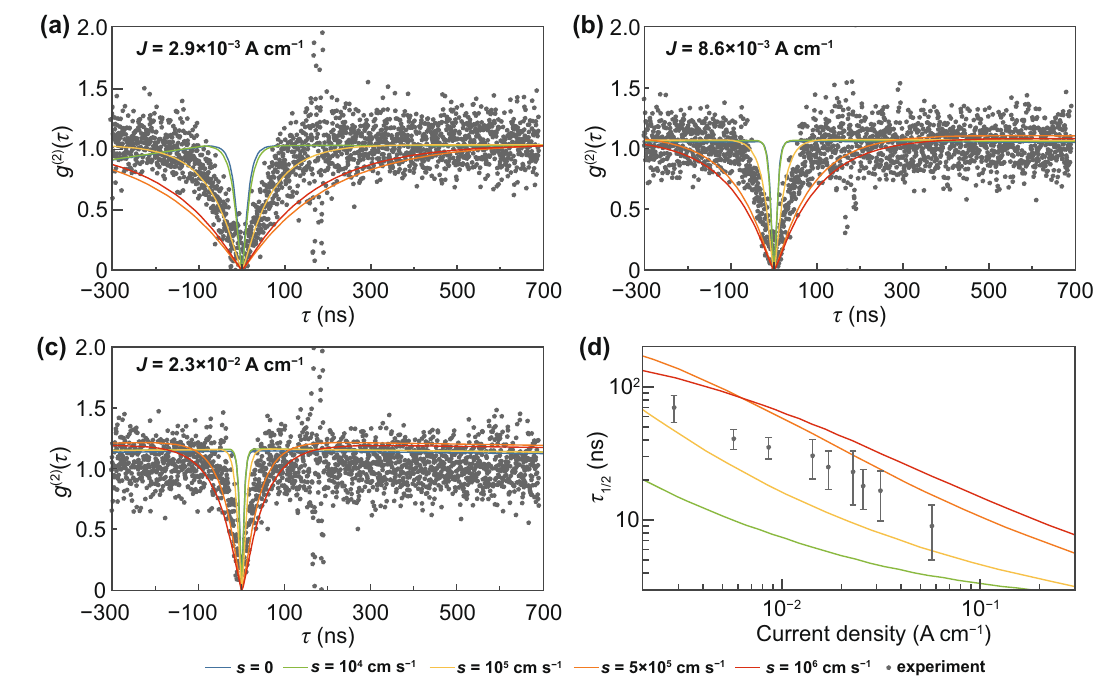
Fig. 4 a–c Numerically simulated g (2) functions and the experimental g (2) curves retrieved from Ref. [24] at current densities of 2.9 ( a ), 8.6 ( b ), and 23 ( c ) mA cm −1 . d Comparison between the numerically simulated g (2) function half-rise time and the g (2) function half-rise time obtained in the experiment. In all panels, the g (2) functions are simulated using the hole capture constant given by the cascade capture model c p− = 2.8 × 10 −7 cm 3 s −1 and the electron capture constant from Table 1